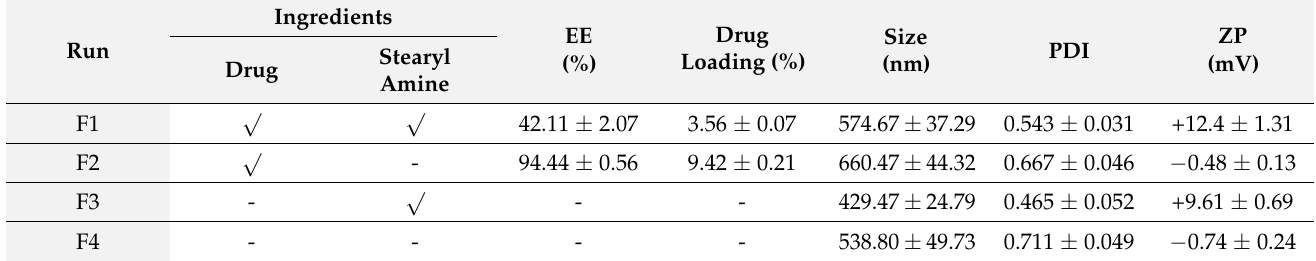
Table 1. Formulation ingredients and characterization of the prepared liposomal